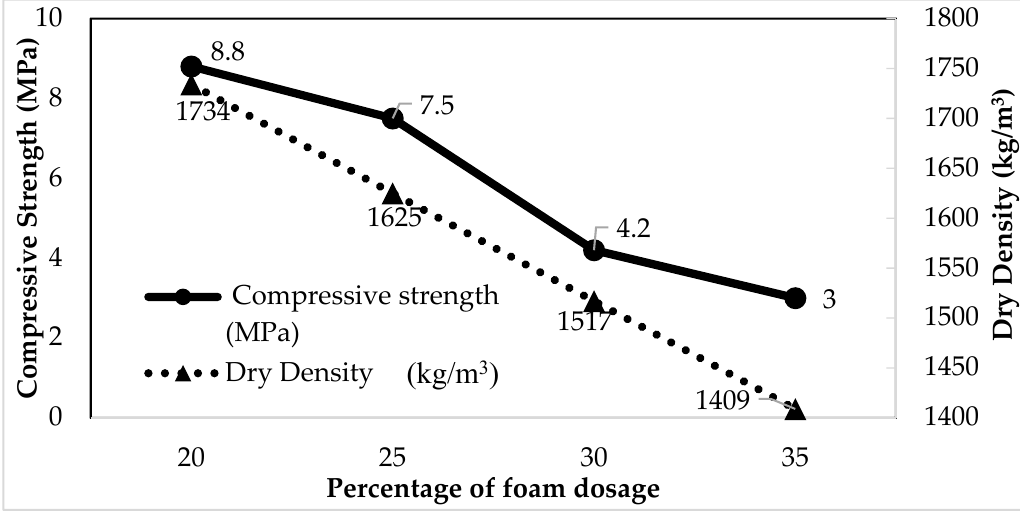
Figure 4. Relationship between compressive strength and density of control FC due to foam dosage.